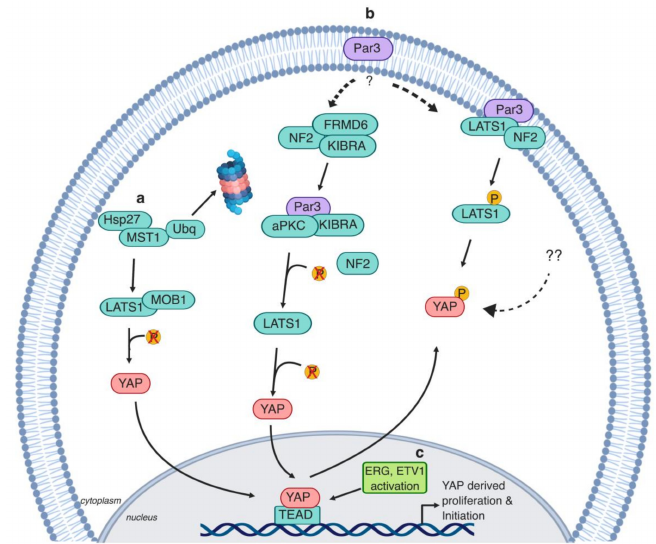
Figure 3. Mechanisms of YAP regulation in early stages of prostate cancer. a. Heat shock protein 27 (Hsp27) induces MST1 ubiquitin-mediated degradation, which in turn causes LATS1 and MOB1 dephosphorylation and thereby inactivation, consequently inducing YAP nuclear translocation [88]. b. Two di ff erent mechanisms were proposed by which polarity protein (Par3) regulates YAP; (1) Par3 inhibits YAP activity through inducing the recruitment of Neurofibromatosis type 2 (NF2 / Merlin) and LATS1 to the membrane. As a result, LATS1 is activated, which induces YAP phosphorylation and cytoplasmic retention [83]. (2) Par3 induces YAP activation through the dissociation of kidney- and brain-expressed protein (KIBRA) from its canonical complex (KIBRA / NF2 / FERM domain-containing protein 6 (FRDM6)) and drives the recruitment of KIBRA to the Par3 / aPKC / KIBRA complex. Thus, the interaction between KIBRA and LATS1 is disrupted, which induces LATS1 dephosphorylation and thereby YAP activation [84]. c. E26 transformation-specific (ETS) transcription factors trigger YAP induction. (1) ETS-regulated gene (ERG) activation drives YAP activation in old aged mice. ERG induces YAP and TEAD4 promoter activity and thereby triggers YAP target gene expression